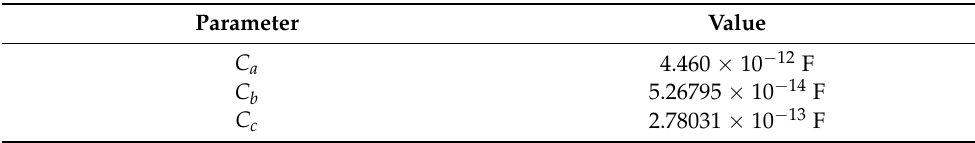
Table 2. Simulation Parameters (Epoxy Resin).